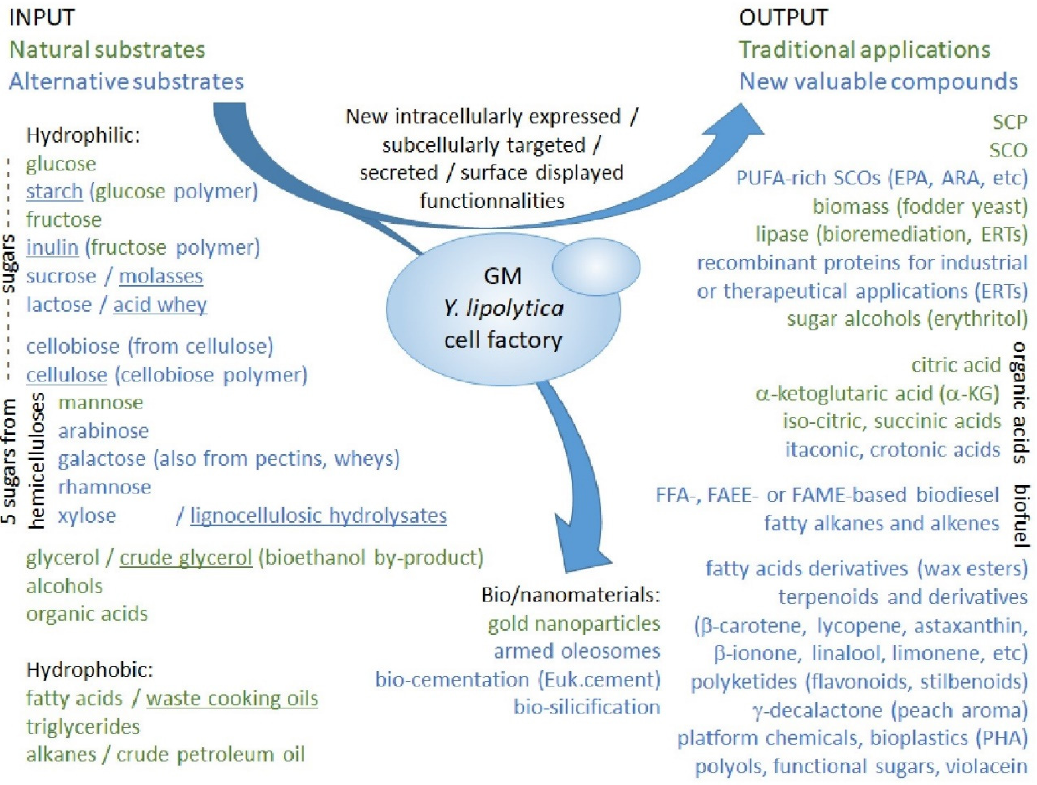
Figure 1. Schematic representation of genetically engineered Y. lipolytica cell factories as a generic “black box”, with exploitable substrates as input and potential applications and products as output.